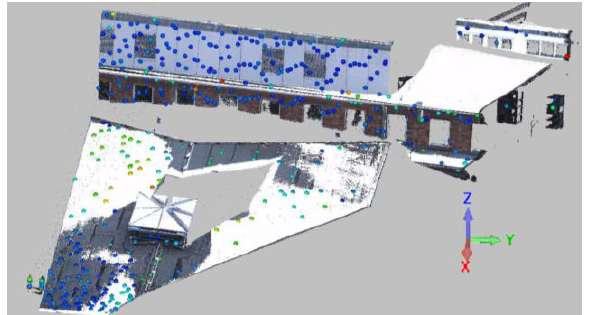
Figure 3: Colour coded visualisation of all applied tie points